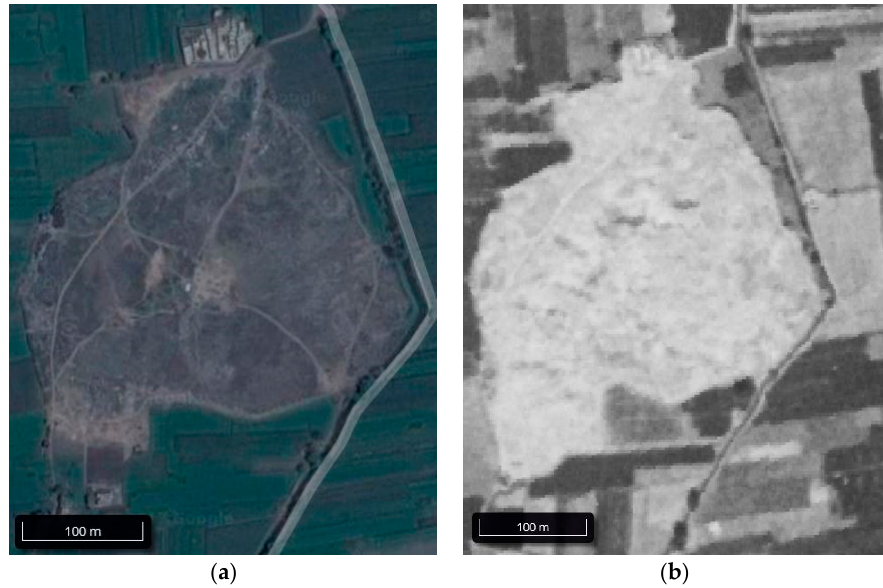
Figure 9. ( a ) The site of Kom Biltus. Image courtesy Google Earth; ( b ) 1968 CORONA image. Image courtesy of the Center for Advanced Spatial Technologies, University of Arkansas/U.S. Geological Survey.